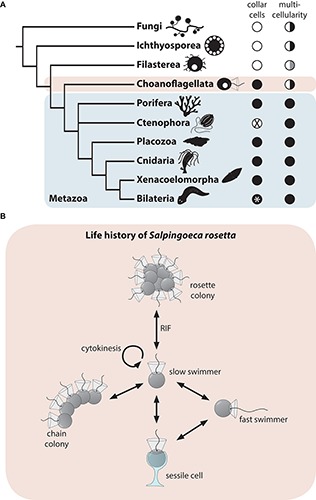
(A) Phylogenetic tree showing Choanoflagellata as sister group of the Metazoa (Steenkamp et al., 2005; Carr et al., 2008; Ruiz-Trillo et al., 2008; Adl et al., 2019). In addition, the presence (black circle) and absence (white circle) of collar cells and multicellularity across lineages are shown (Brunet and King, 2017; Laundon et al., 2019). The white asterisk indicates independent secondary losses. Half-filled circles indicate multicellularity in only some species. In Filasterea, multicellularity is achieved by aggregation of single cells (half-filled white-gray circle) instead of clonal division. (B) Life history of the choanoflagellate S. rosetta after Dayel et al. (2011). RIF, rosette inducing factor (Alegado et al., 2012).